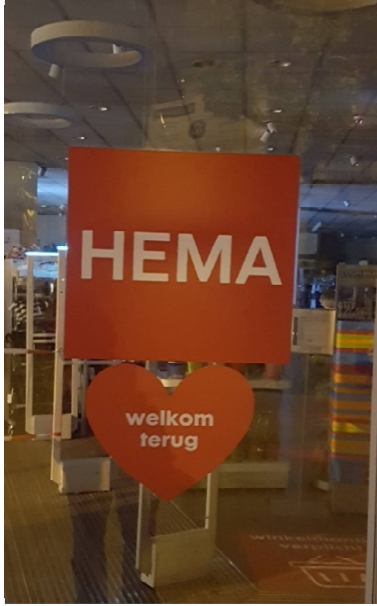
Figure 11. HEMA Welcome back.